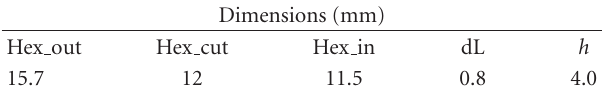
Table 2: Unit-cell dimensions for dual hexagonal AMC.